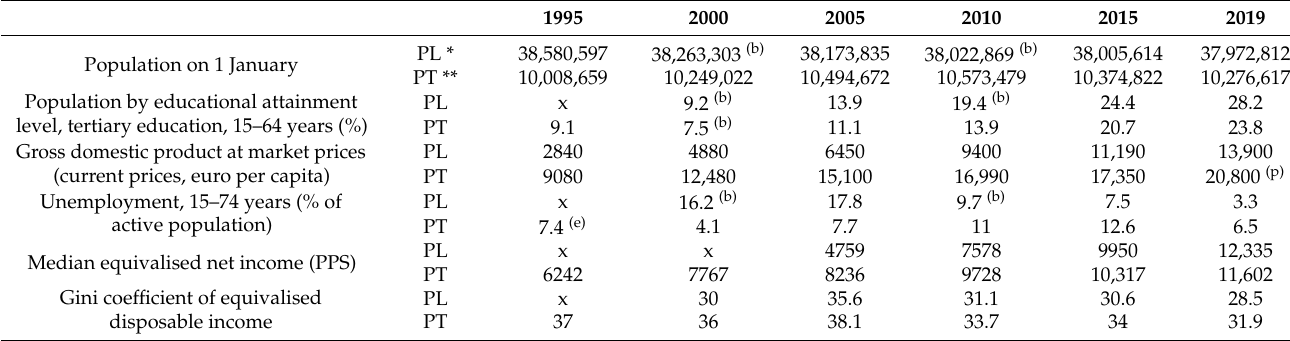
Table 1. Basic characteristics of the examined countries, 1995–2019.